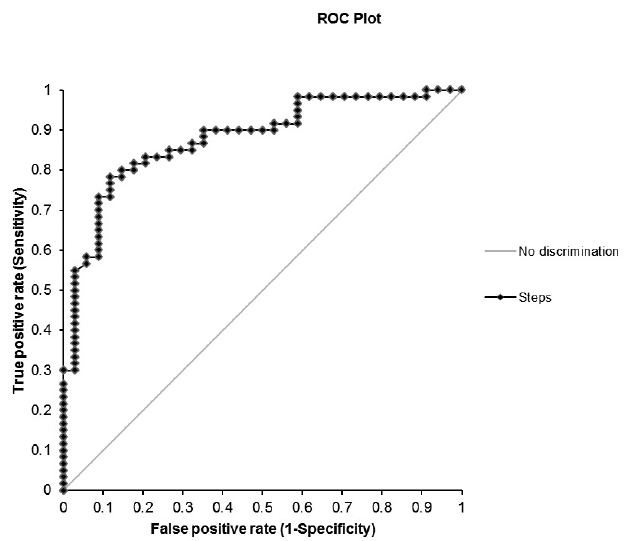
Figure 1. ROC curves for step-counts (AUC=